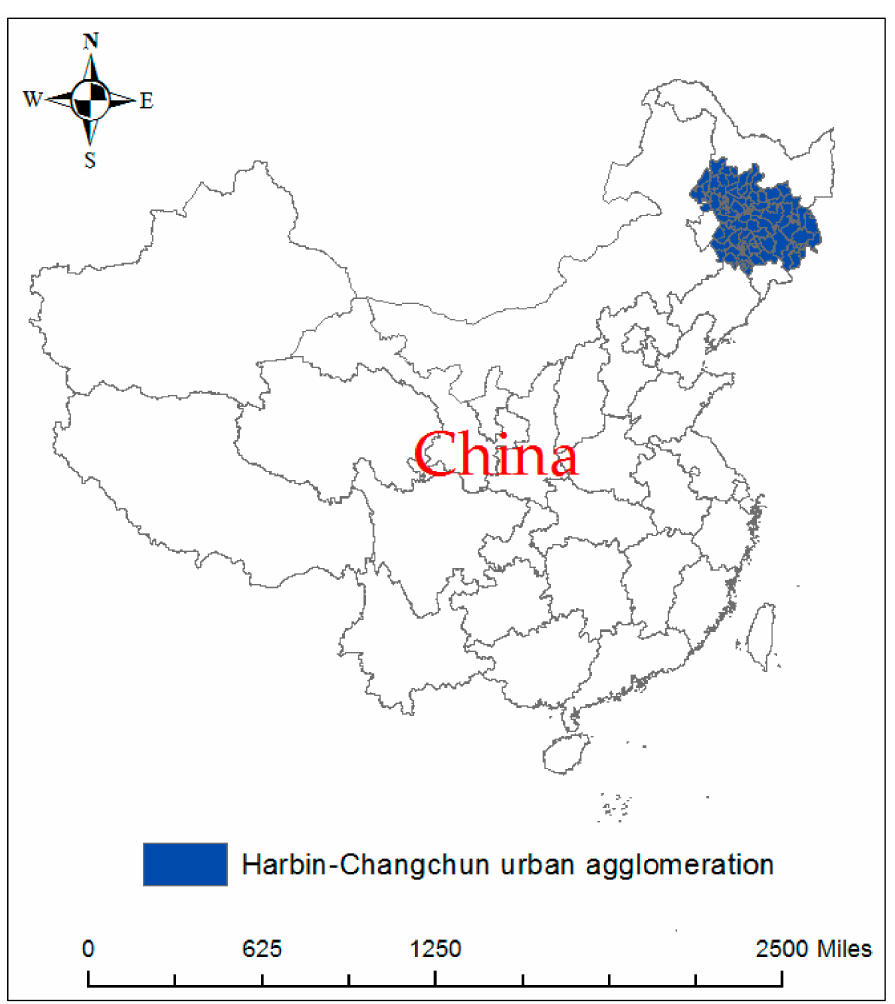
Figure 1. The Harbin–Changchun urban agglomeration in